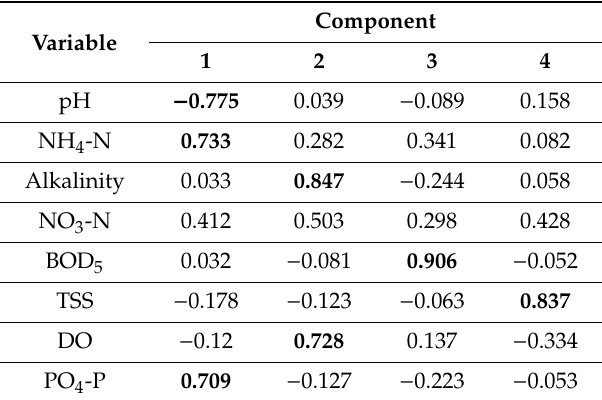
Table 4. Rotated component matrix extraction method: principal component analysis; rotation method: varimax with Kaiser normalization—marked loadings are >0.70 (rotation converged in 6 iterations)—Tandarei dataset.